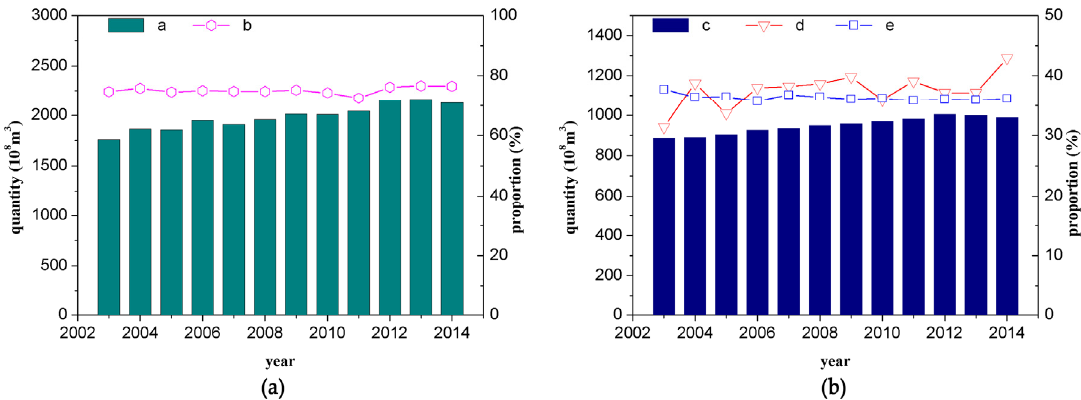
Figure 2. ( a ) Agricultural water consumption in northern China; ( b ) Groundwater conditions in northern